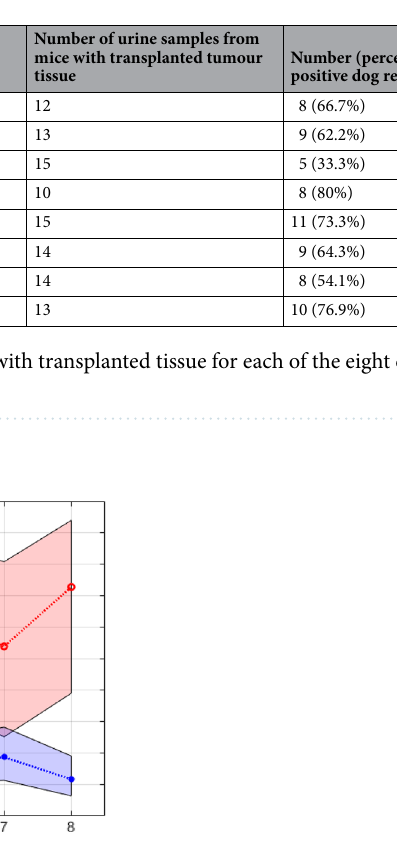
Figure 4. Relative frequency of true positive and false positive responses of dogs to urine samples collected by day. Red and blue markers show the proportions of true positive and false positive reactions of dogs to urine samples, respectively. The shaded areas correspond to the 95% confidence interval for each of the 8 days of